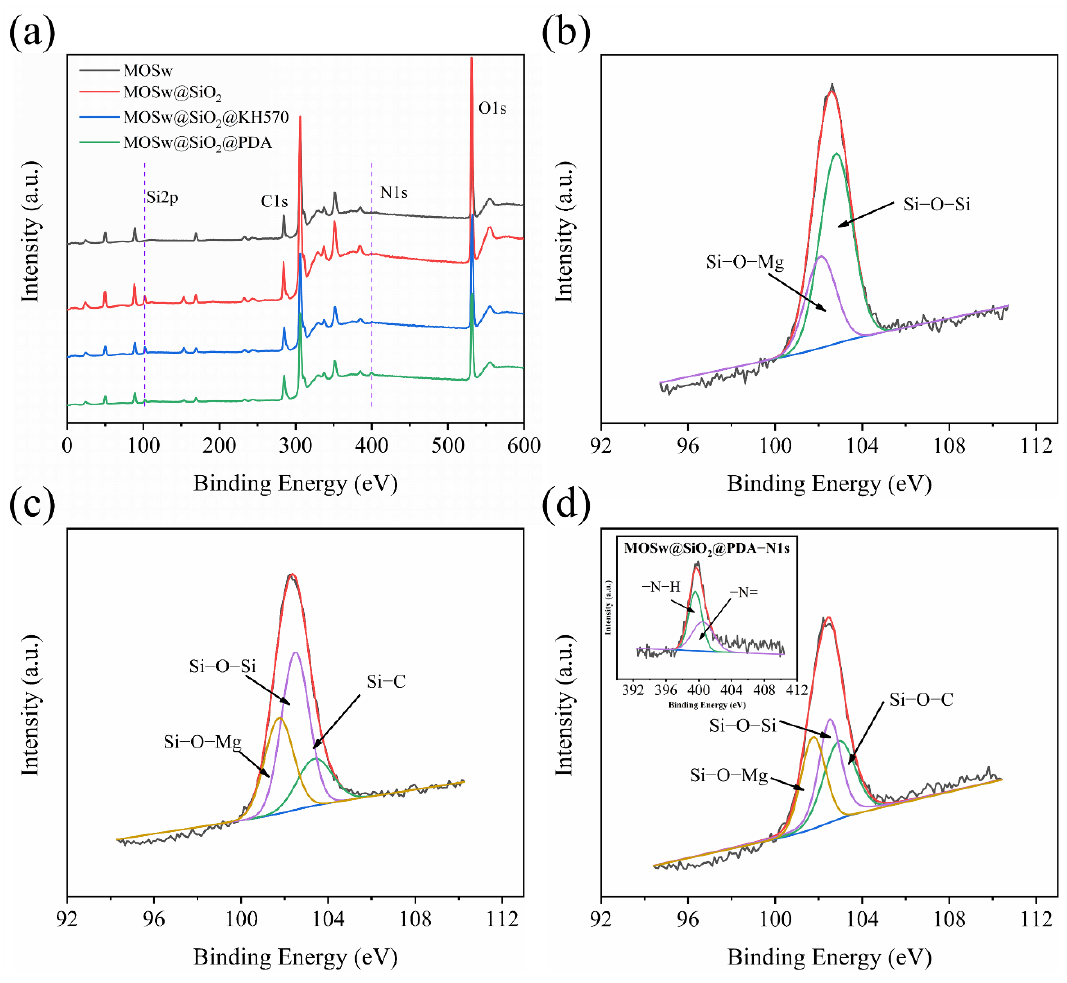
Figure 2. XPS spectra, Si2p for ( a ) Unmodified MOSw, ( b ) MOSw@SiO 2 , ( c ) MOSw@SiO 2 @KH570,